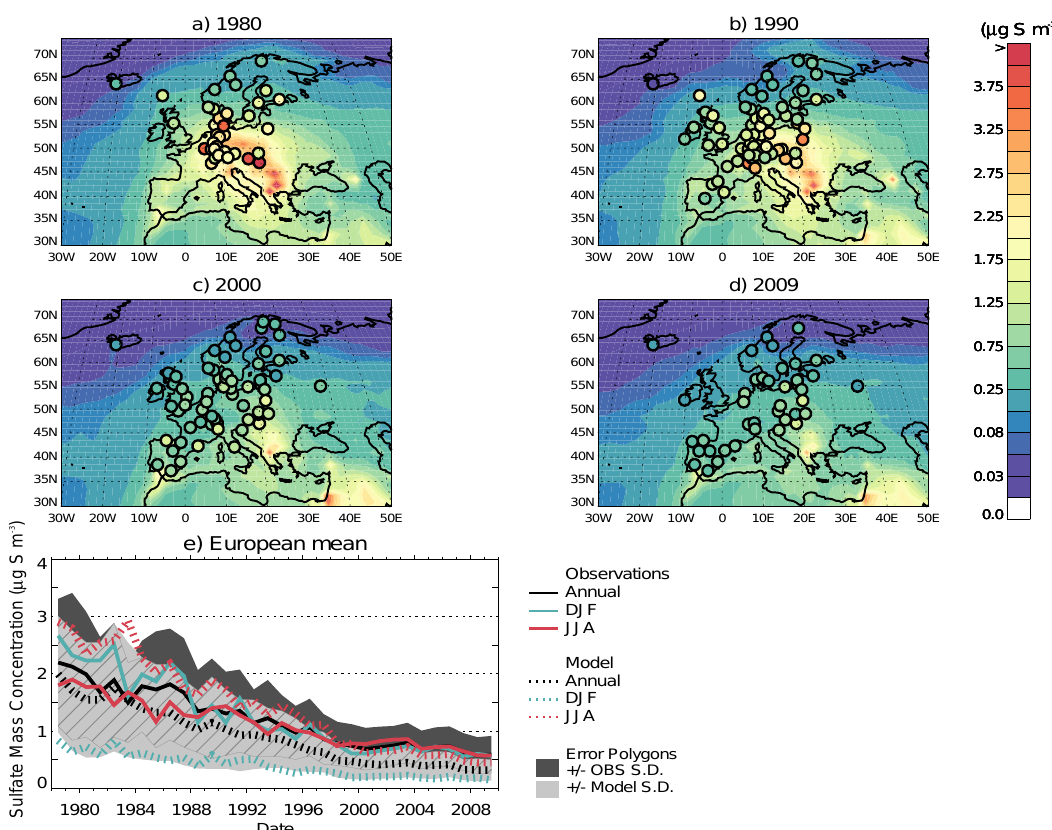
Figure 5. Annual mean sulfate aerosol mass concentrations (µgSm − 3 ) from the lowest model level with observations overplotted in circles for (a) 1980, (b) 1990, (c) 2000 and (d) 2009. (e) Time series of annual and seasonal mean observed (solid lines) and modelled (dashed lines) sulfate concentrations averaged across all measurement locations for each particular year. Shaded areas show ± 1 standard deviation of the modelled (light grey) and observed (dark grey) annual mean values, with the hatching identifying areas of